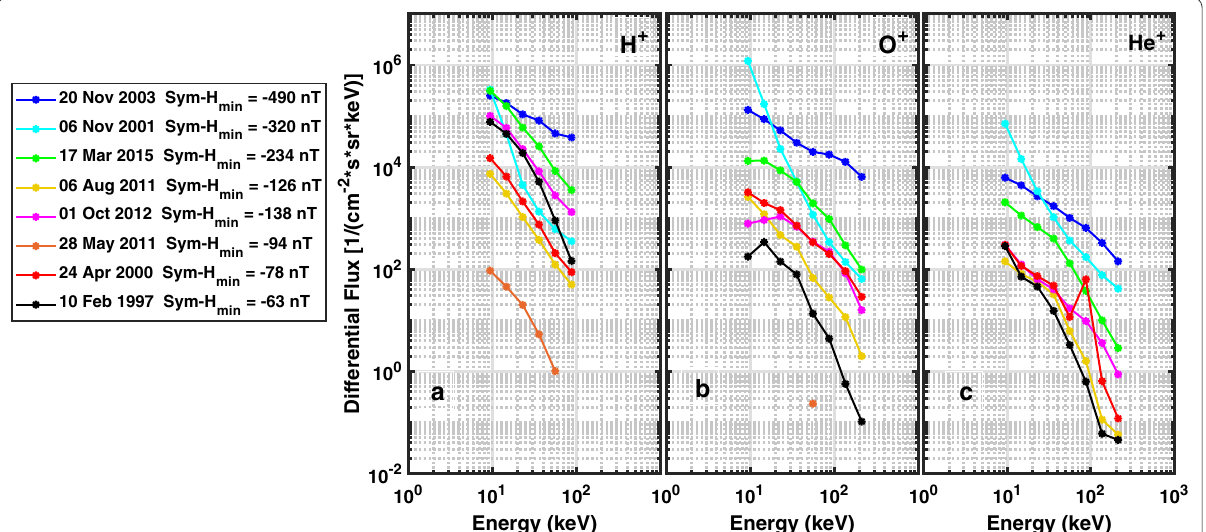
Fig. 9 Energy spectra for a H + , b O + and c He + ions using Geotail observations for all the geomagnetic storms in this study at main phase is shown. The legend corresponds to Sym-H (min) for each magnetic